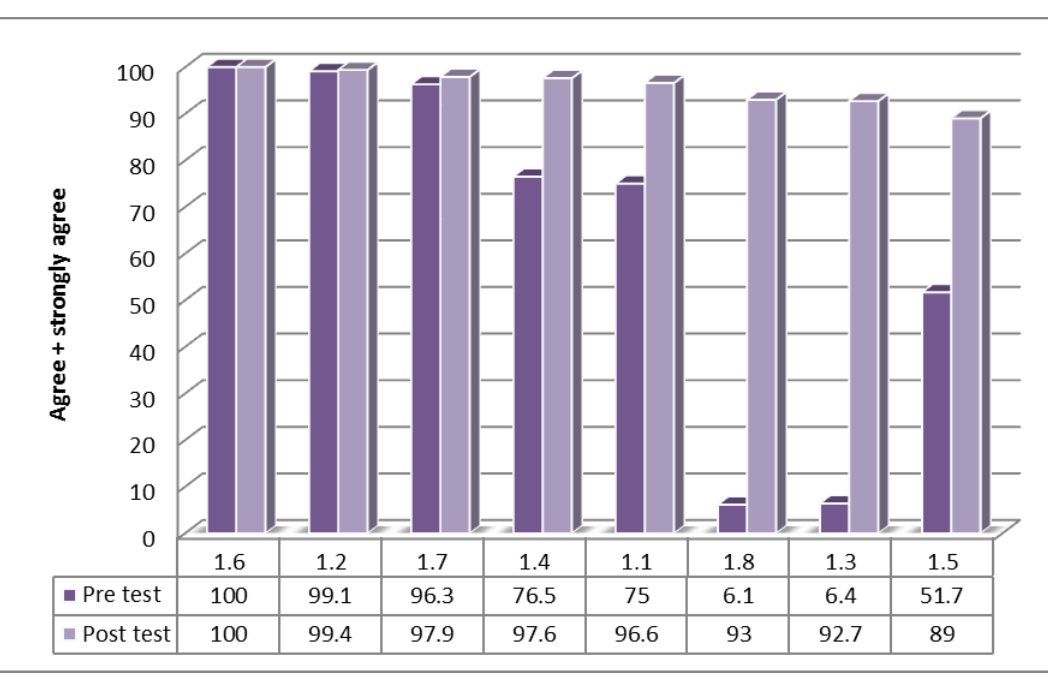
Figure 1. Dimension 1. Concepts and opinions regarding open